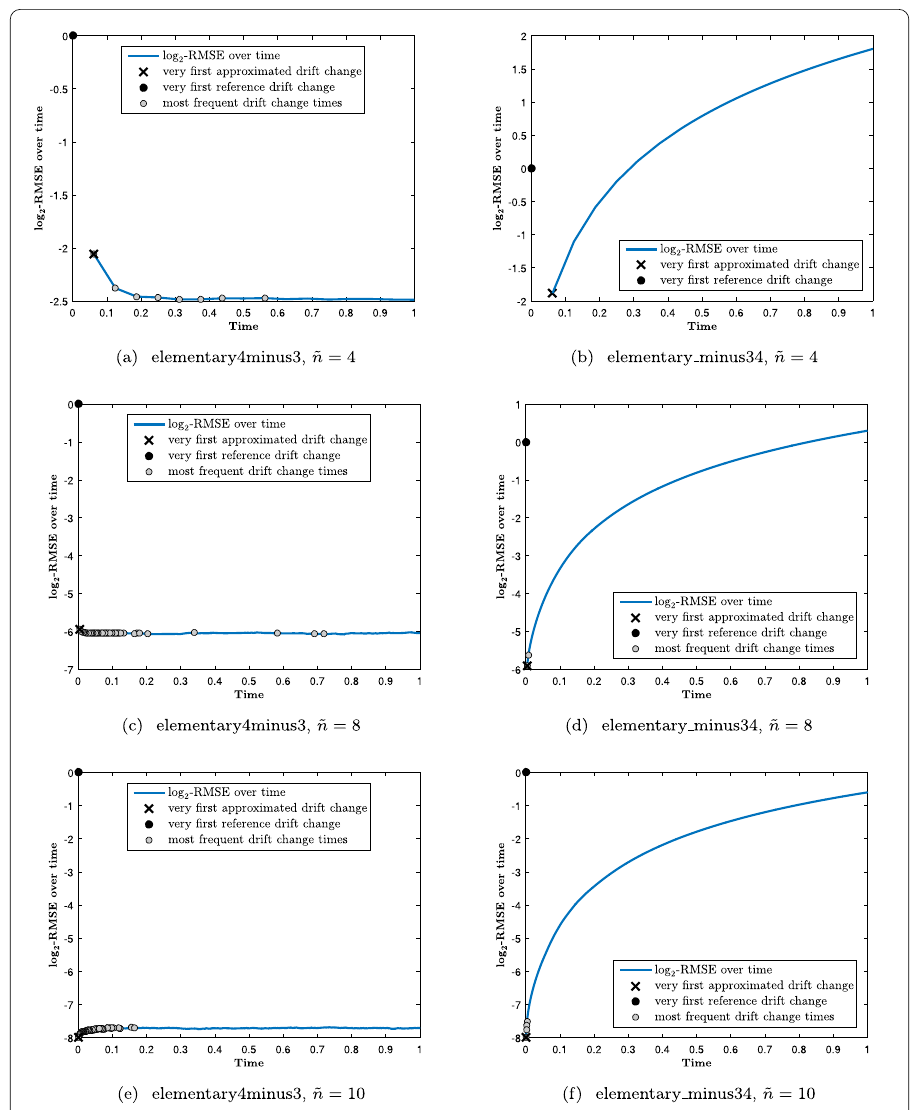
Figure 4 Comparison of the error evolution over time for ξ = 1.4 for different step sizes: elementary4minus3 vs.